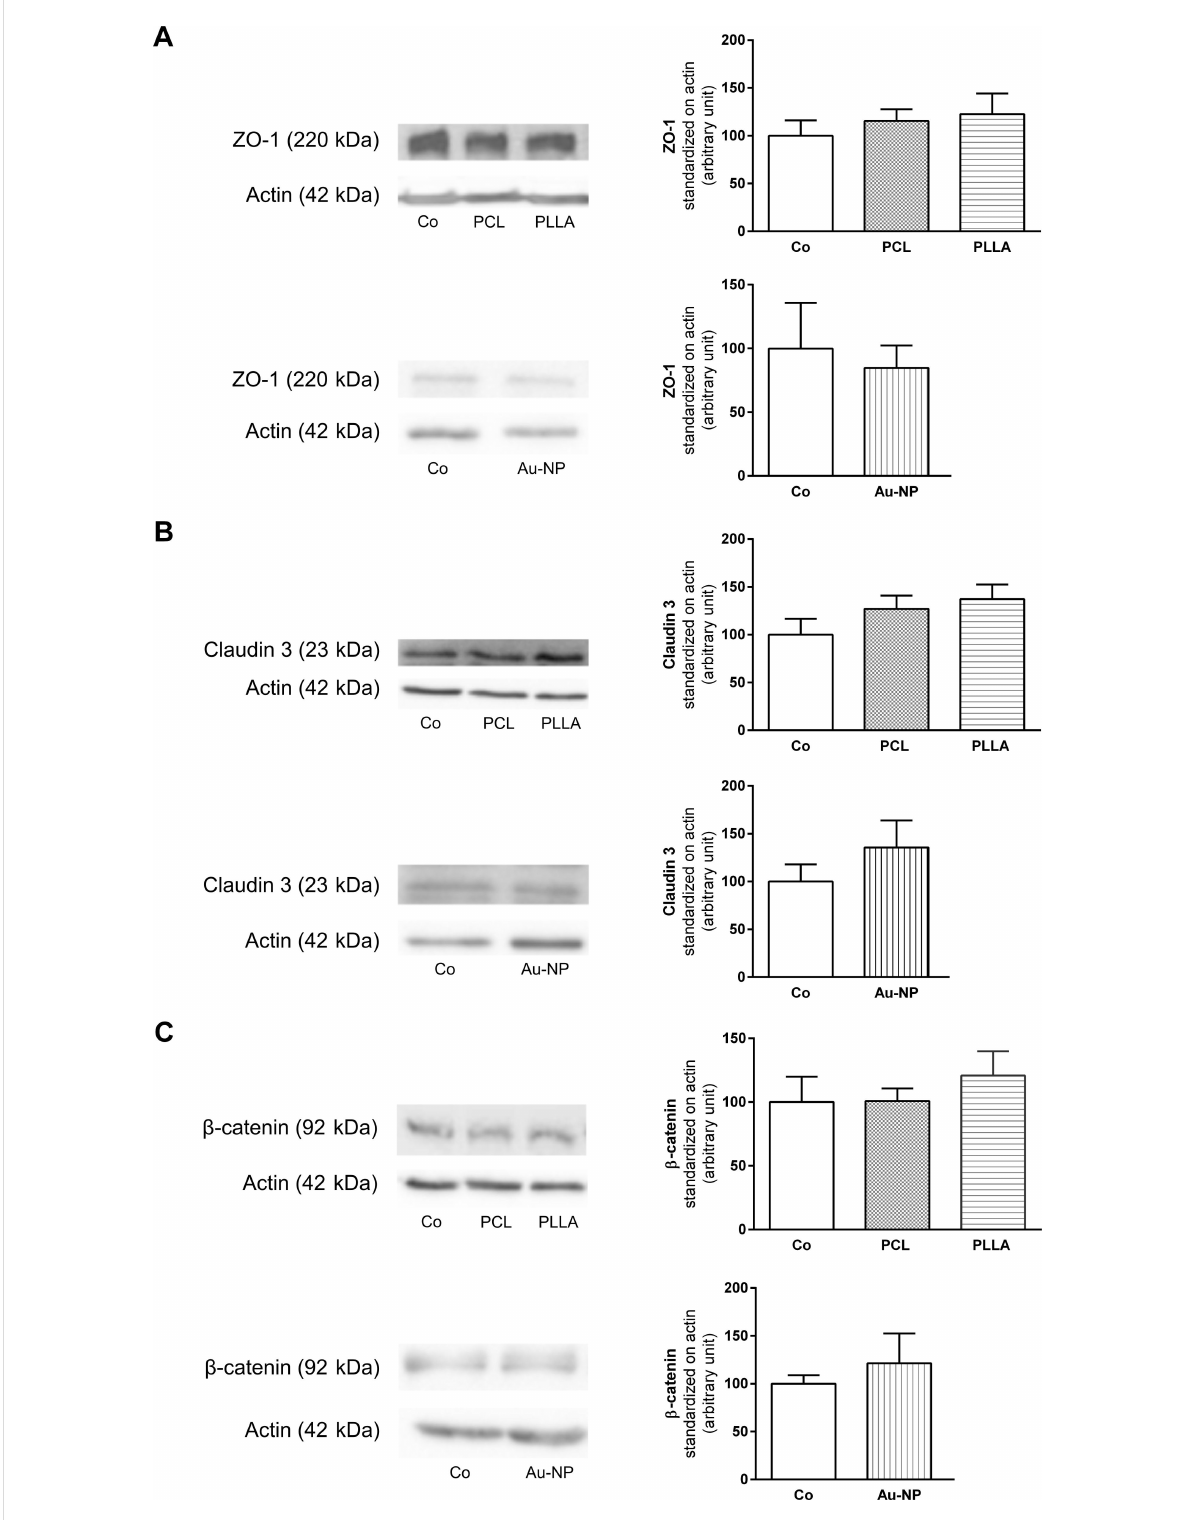
Figure 6: Effects of PCL-, PLLA- and Au-NPs on expression and regulation of TJs in rBCEC4 cells. Expression levels of ZO-1 (A), claudin 3 (B) and β -catenin (C) were evaluated and quantified. None of the NPs exhibited an effect on the expression levels of these proteins. Representative western blot images are depicted on the left, corresponding quantifications are shown on the right. Co: control. Concentrations were [24.9 µg/mL] for PCL- and PLLA-NPs and [160.3 µg/mL] for Au-NPs. Error bars represent